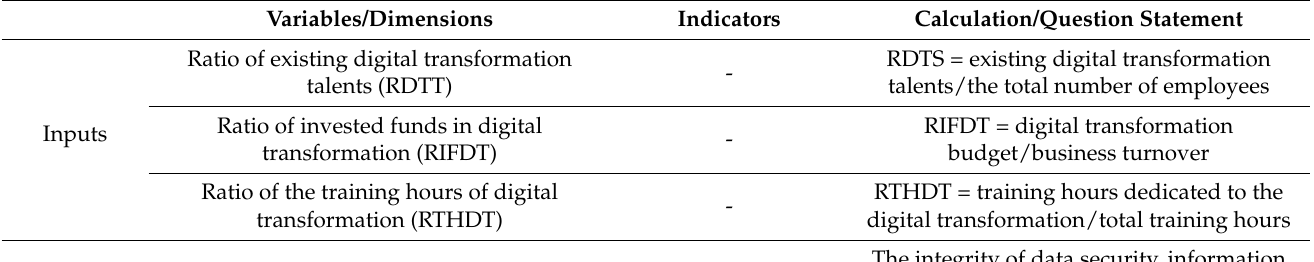
Table A1. Dimensions of the retail vendor digital transformation progress framework and their corresponding